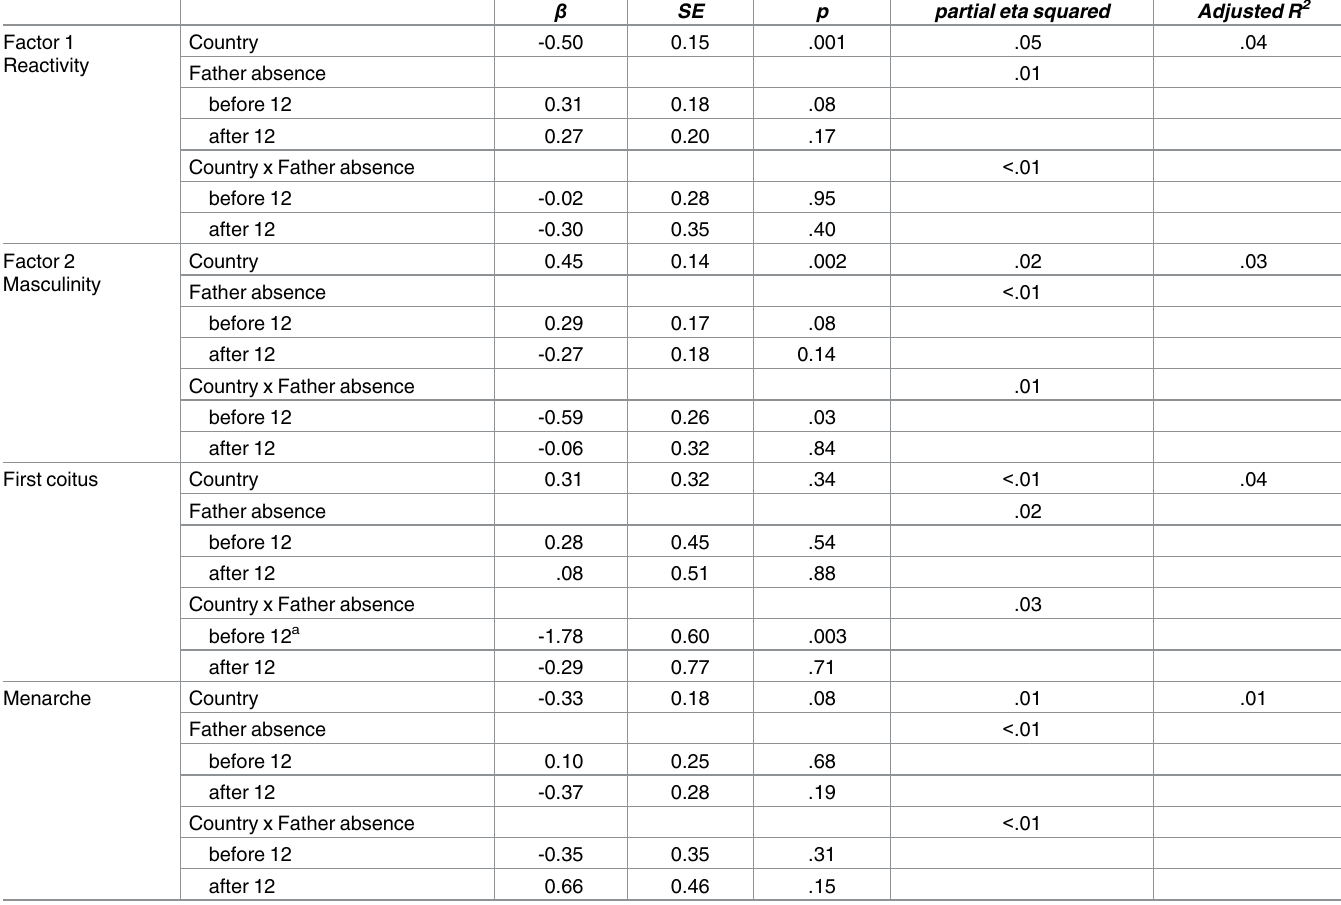
Table 3. Regression analysesshowing associations between father absence and outcome measuresfor female participants. (Referencecategory for Country is